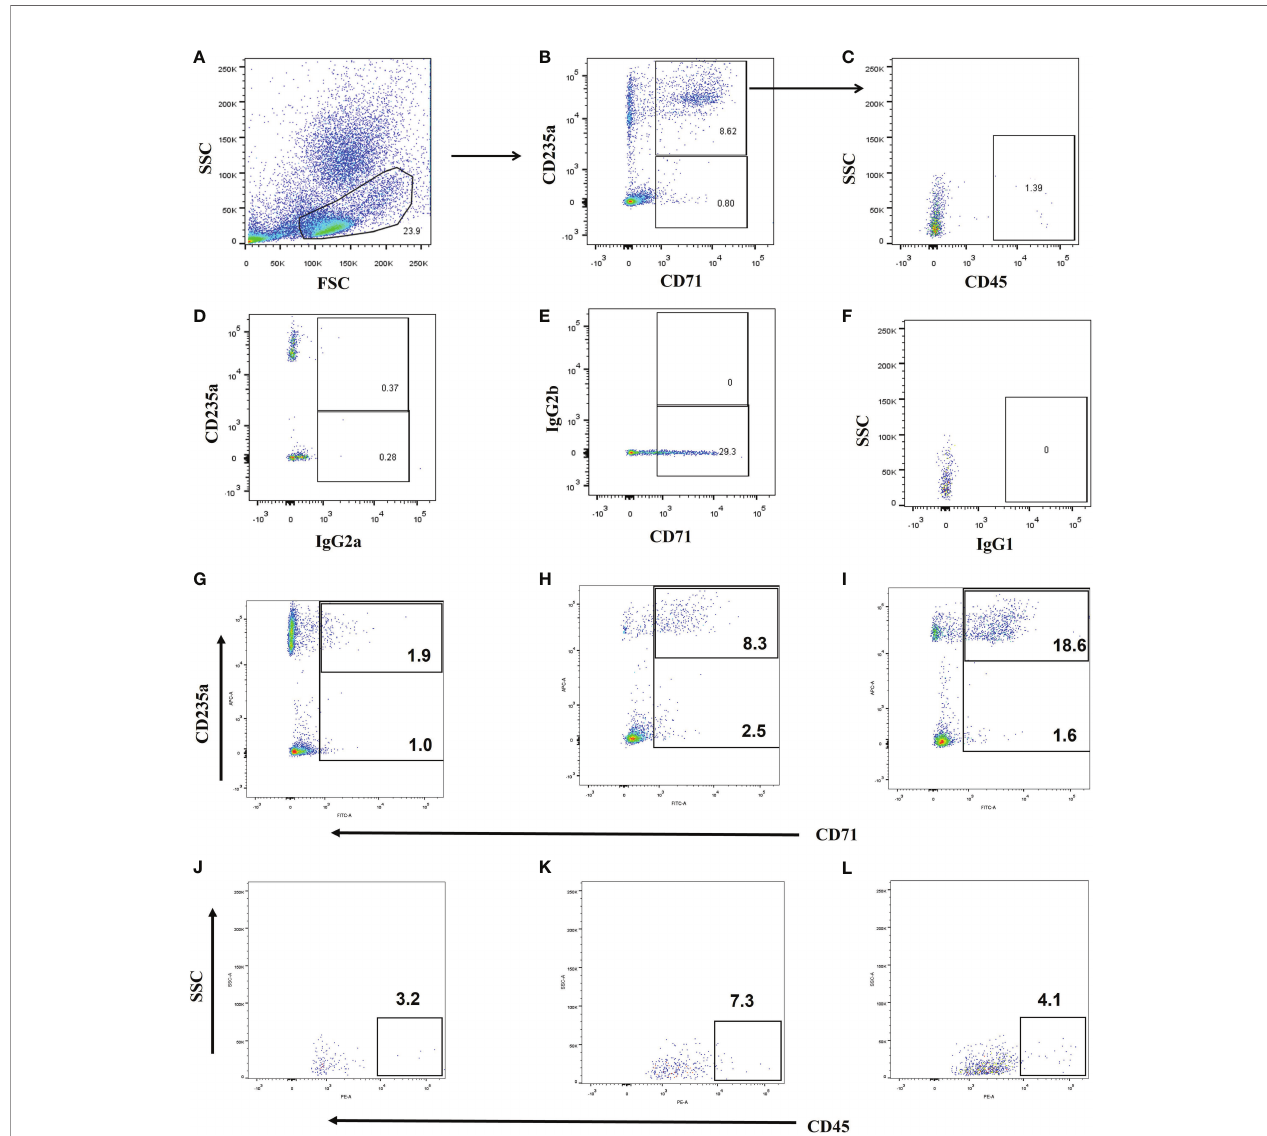
FIGURE 2 | Gating strategy and representative fl ow cytometry plots. (1) Gating strategy for CD71 + cells, CD71 + CD235a + cells, and CD71 + CD235a + CD45 + cells (A – C) . CD71 + CD235a - cells, and CD71 + CD235a + cells were gated from peripheral blood mononuclear cells (PBMCs), and then CD71 + CD235a + CD45 + cells were gated from CD71 + CD235a + cells. The total percentages of CD71 + cells, CD71 + CD235a + cells, and CD71 + CD235a + CD45 + cells were calculated and recorded, respectively. (2) Fluorescence minus one (FMO) isotype control for proper identi fi cation of CD71 + (D) , CD235a + (E) and CD45 + cells (F) . (3) Representative fl ow cytometry plots for the assessment of CD71 + cells, CD71 + CD235a + cells, and CD71 + CD235a + CD45 + cells in ICU control (G, H) , septic patients (I, J) , and septic patients who had nosocomial infection and died (K, L)